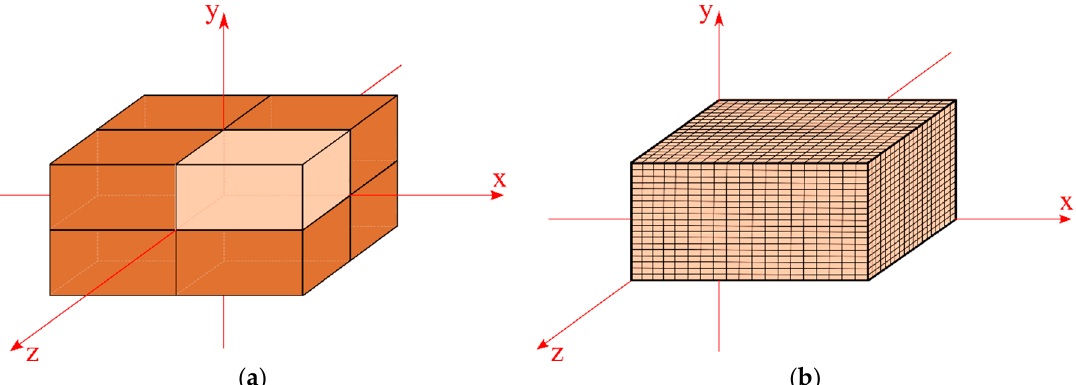
Figure 2. Parallelepipedic solid. ( a ) Geometry of the studied solid and ( b ) mesh characterization of 1 / 8 of studied solid.